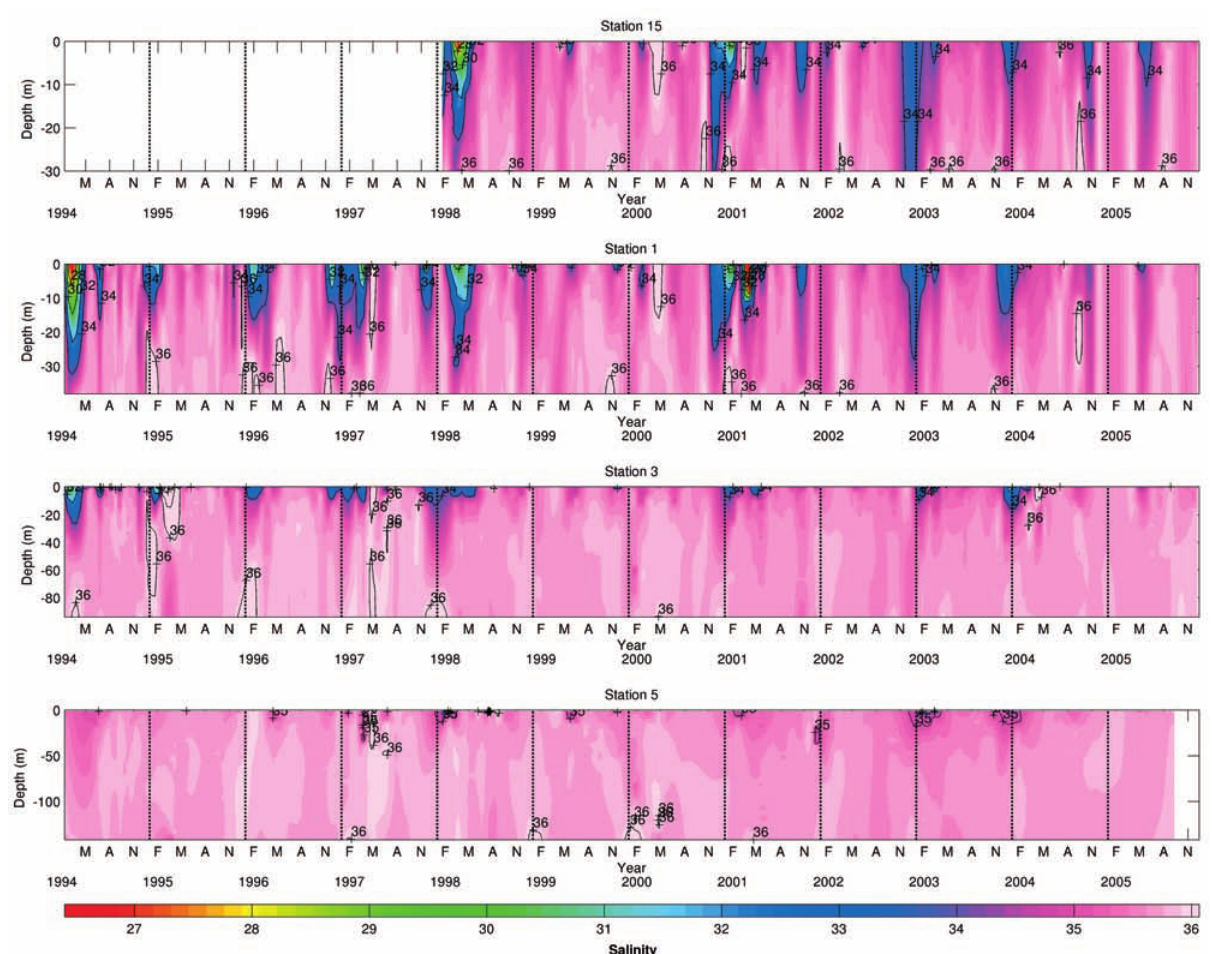
Fig . 9. – Full-depth long-term salinity recorded at the sampling stations from January 1994 to December 2005. Stations are plotted from the inner (top panel; St.15) to the outer (bottom panel; St.5) location with the same color scale. White areas represent a lack of